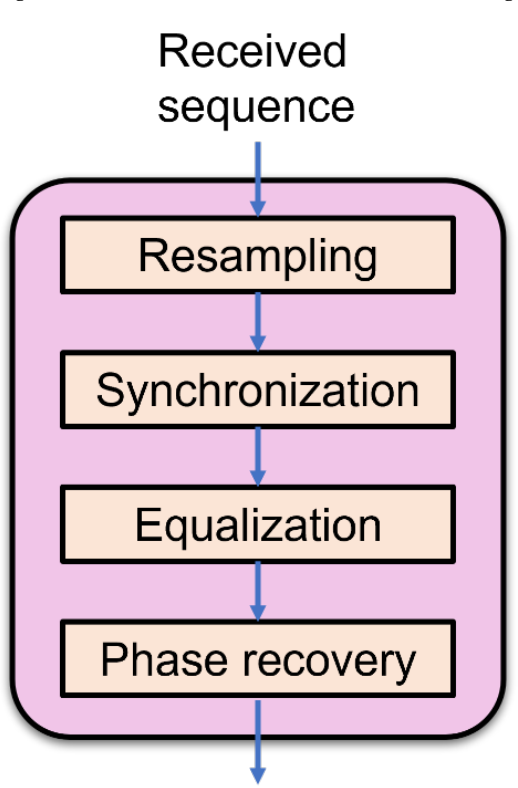
Figure 5. The configuration of the DSP progress for 16QAM.